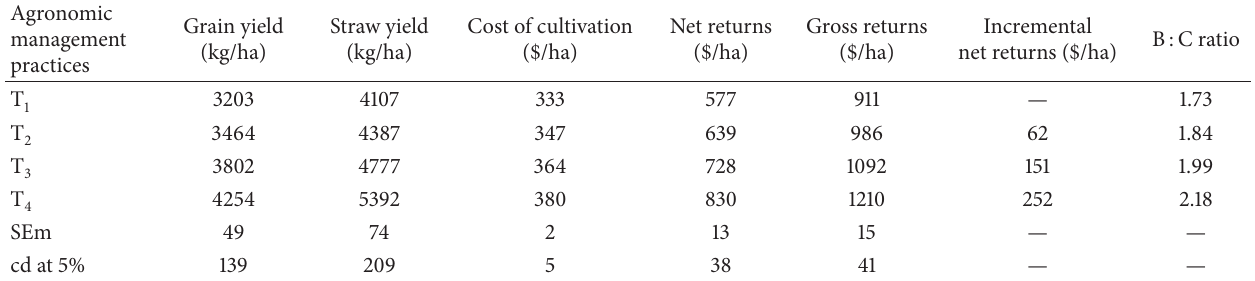
Table 3: Grain and straw yield and economics of different agronomic management practices in wheat crop (pooled data of four years).